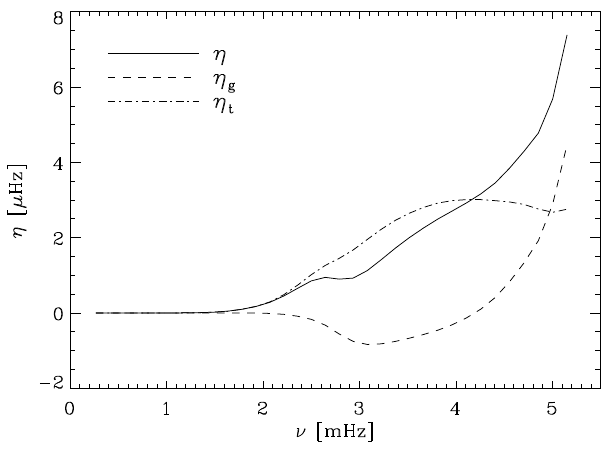
Figure 9: Linear damping rates 𝜂 for a solar model as a function of cyclic frequency. Contributions from the modulation of the radiative and convective heat flux, 𝜂 g , and turbulent moment flux (turbulent pressure), 𝜂 t , to the total damping rate (solid curve), 𝜂 , are indicated by the dashed and dot-dashed curves respectively. Image reproduced with permission from Houdek et al. (1999a), copyright by